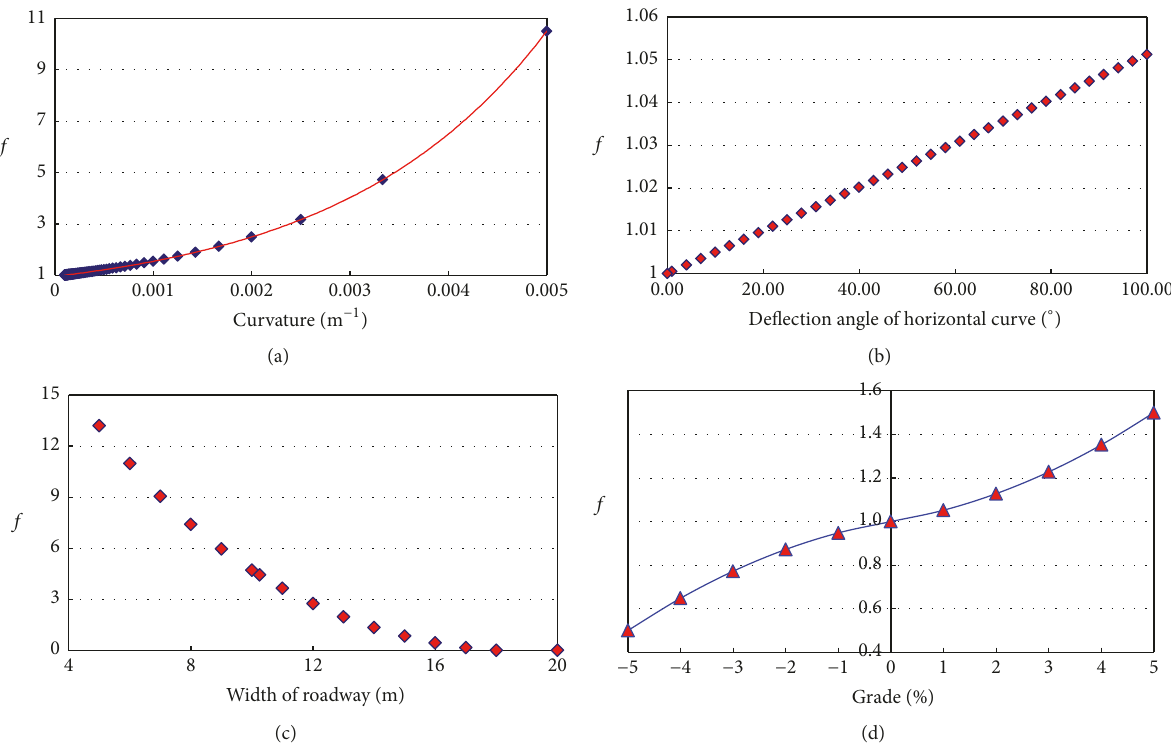
Figure 2: Relation between single index and 𝑓 . (a) Curvature. (b) Deflection angle of horizontal curve. (c) Width of roadway. (d)